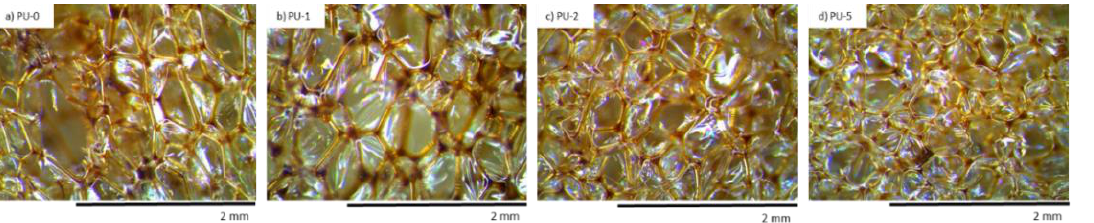
Figure 12. The external surface of PUR composite foams after 7 days of UV aging. Adapted from Ref. [9].